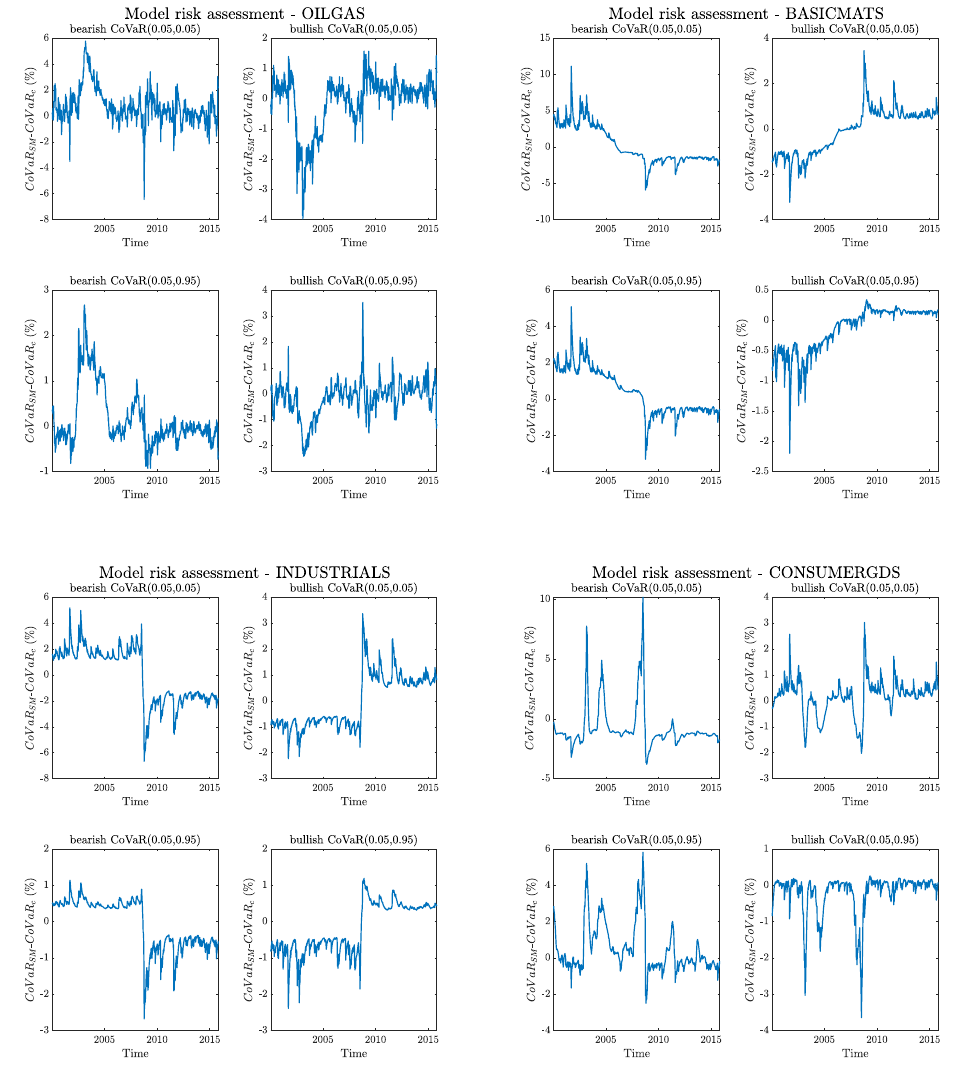
These figures show the difference between the estimation of the same percentile of stock sector returns under the same oil-related scenario using the Switching Markov model that allows for changes in the copula against the constant model. Top figures focuses on a low quantile ( β = 5%) whilst bottom graphs estimate the high quantile ( β = 95%). Left figures show a percentile of stock returns under a bearish scenario for oil returns, i.e. oil returns below its percentile 5%, and right figures show a percentile of stock returns under a bullish scenario for oil returns, i.e. oil returns above its percentile 95%. These charts indicate the higher model risk in the lower tail than in the upper tail when assuming a constant dependence across